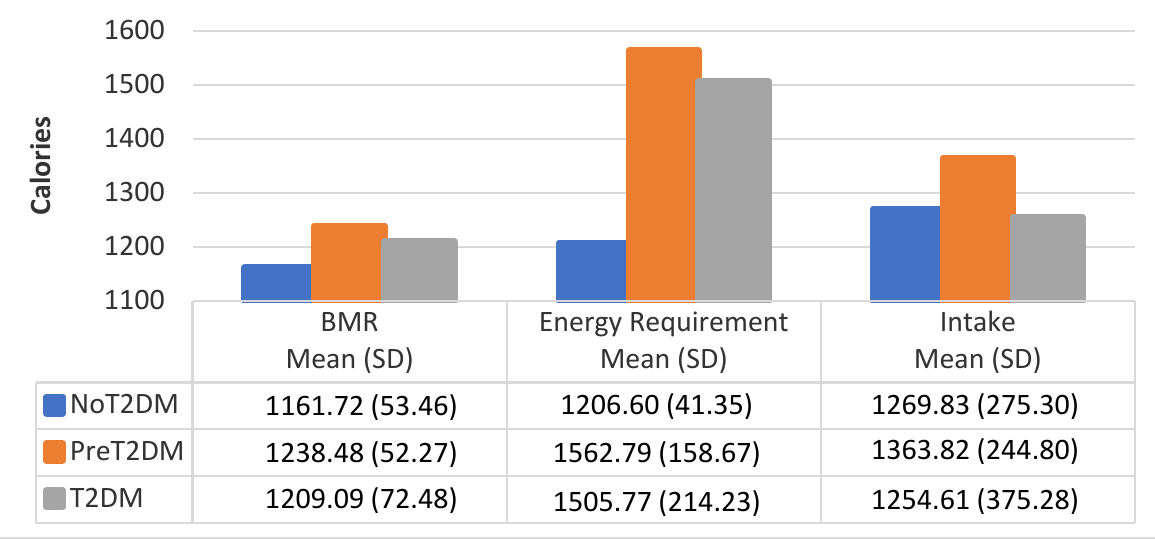
Figure 4. BMR, energy requirement, and caloric intake for female participants by diabetes status.